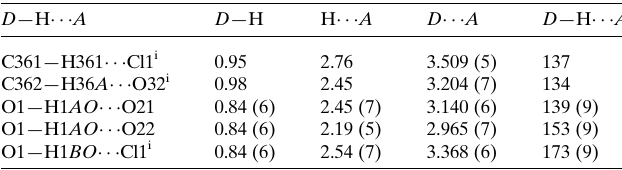
Table 2 Hydrogen-bond geometry (A˚ , (cid:3) ).